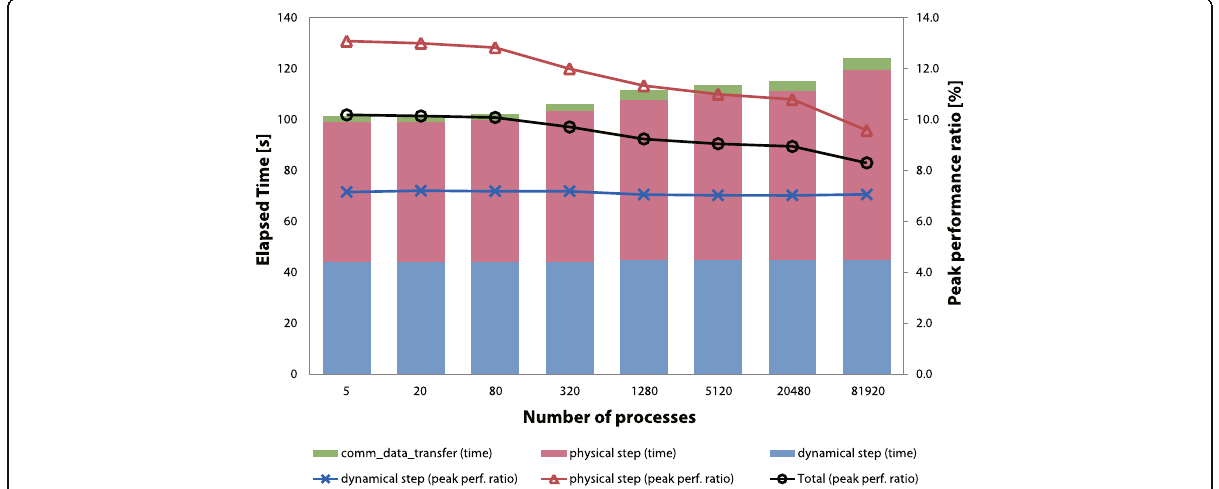
Fig. 1 Results of the weak scaling test on the K computer. Bars show the elapsed time for the dynamical step, the physical step, and the communication (data transfer) step. Lines indicate the sustained performance. After Fig. 2 of Terai et al.